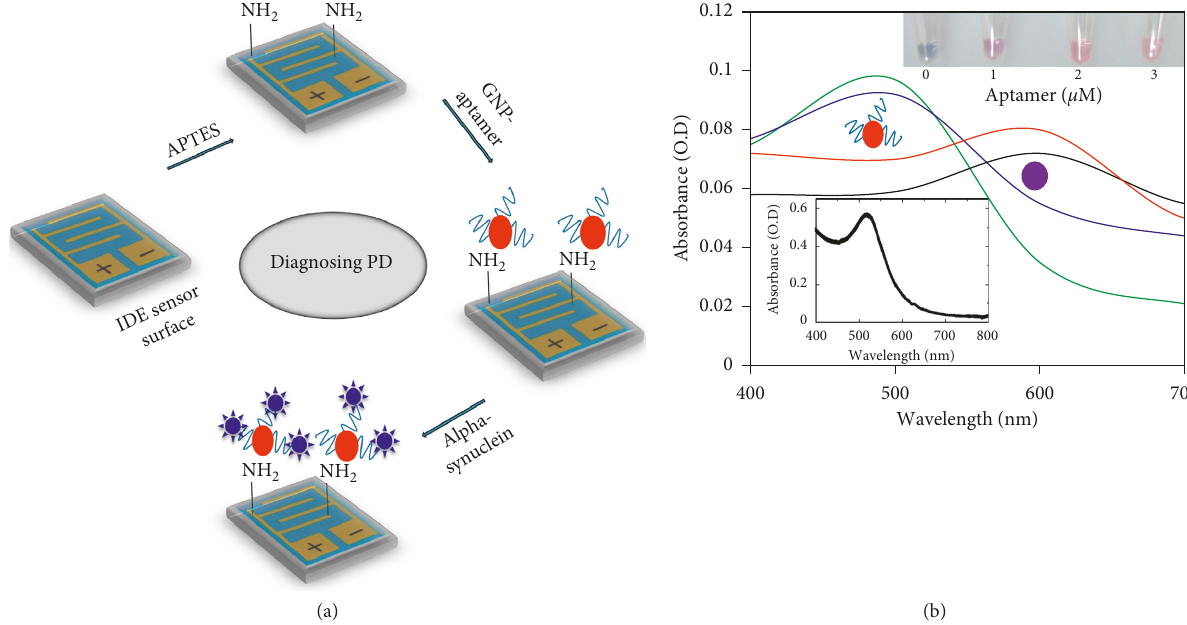
Figure 1: (a) Schematic representation of alpha-synuclein detection by an aptamer-gold nanoparticle probe on an IDE surface. The surface was modified by APTES to immobilize the GNP-aptamer, and then, alpha-synuclein was detected. (b) Colorimetric analysis to reveal the stability of aptamer attachment on the GNPs. Analyses were performed by both colorimetric (figure inset) and spectrophotometric methods. The figure inset graph represents the absorbance maximum of as-received